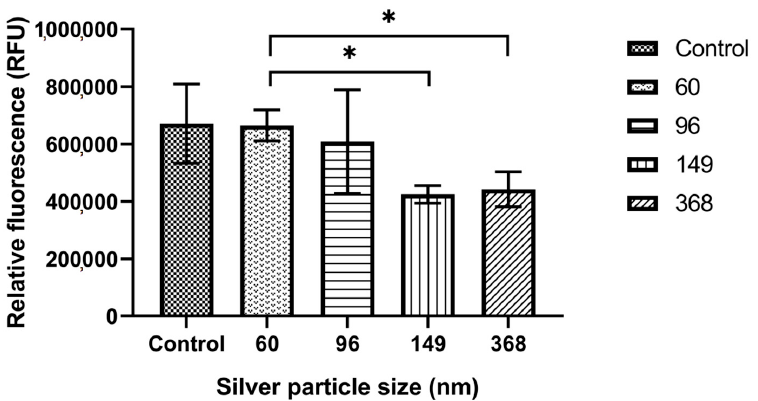
Figure 8. The effect of the diameter of superficial silver nanoparticles on the viability of dental pulp stem cells (DPSCs). Cells were seeded on silver nanoparticle covered titanium discs and cultured for 14 days. Cell viability was measured by Alamar Blue assay. Values are expressed as sample means, and error bars represent the standard deviations ( n = 3). Statistically significant differences are indicated with asterisks (* p <0.01).